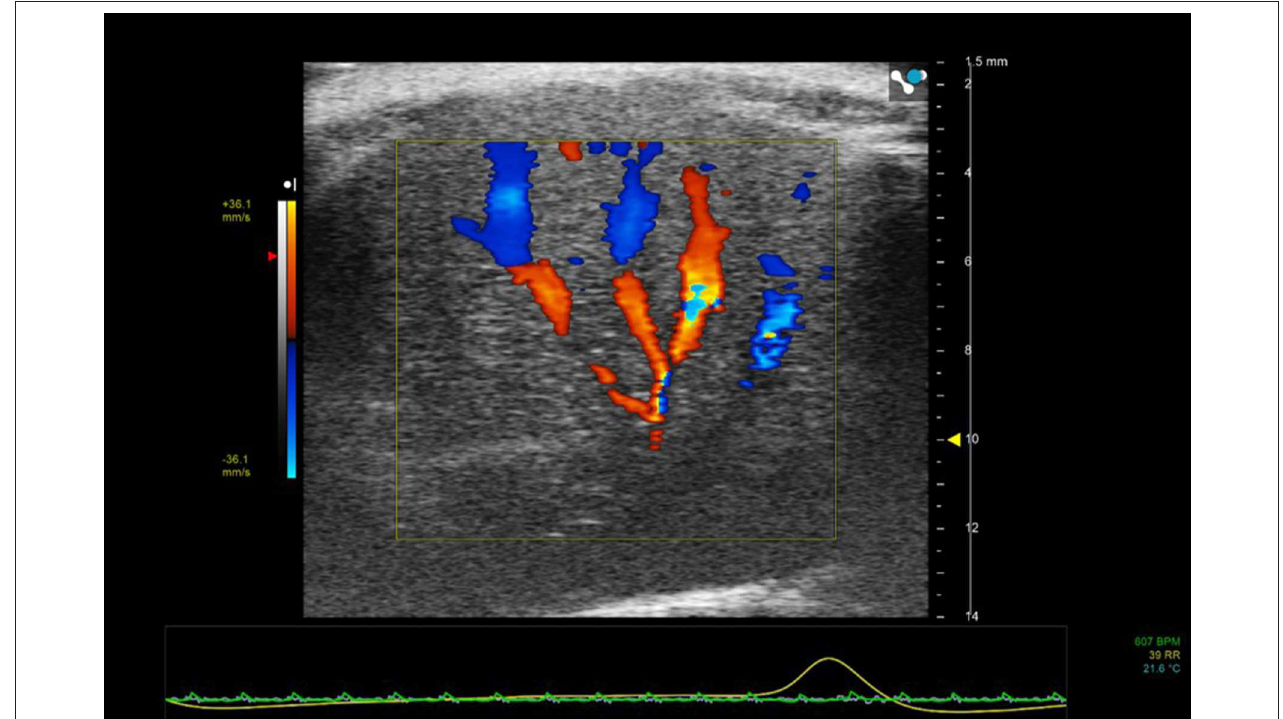
FIGURE 5 | Color Doppler region of interest superimposed on 2D B-mode image of mouse liver. Color Doppler shows the vessel network—blue indicating movement of blood away from the transducer and red toward the